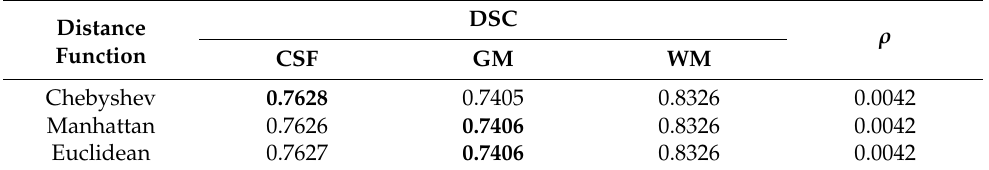
Table 4. Registration results of different distance functions and the best results are shown in bold.